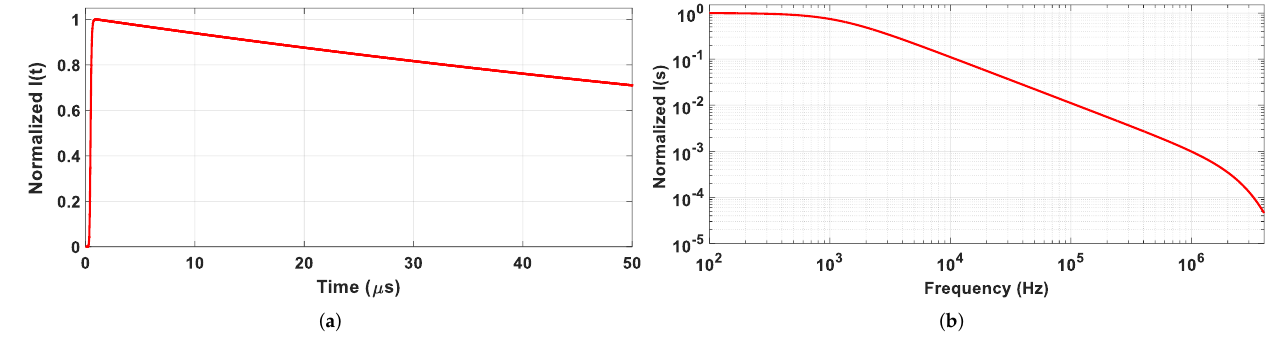
Figure 13. Lightning current injected at the OHTL: ( a ) Time-domain and ( b ) Frequency-domain spectrum.